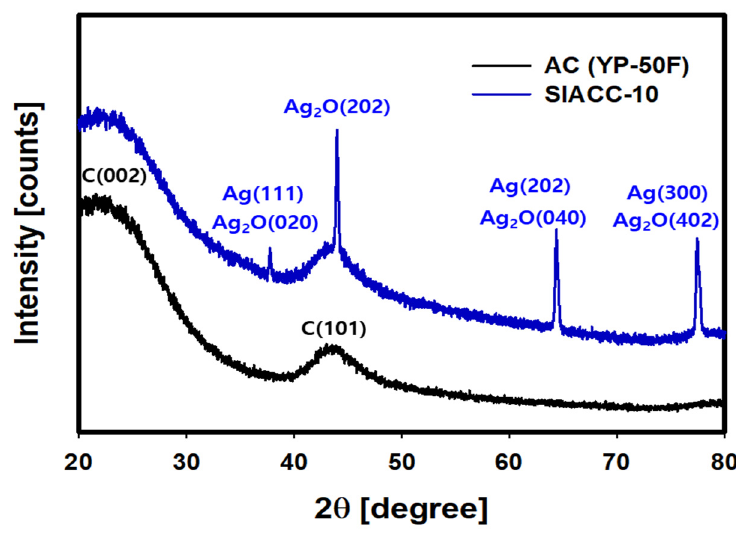
Figure 6. XRD pattern of SIACC-10 prepared by PLP reaction and Bare AC (YP-50F).